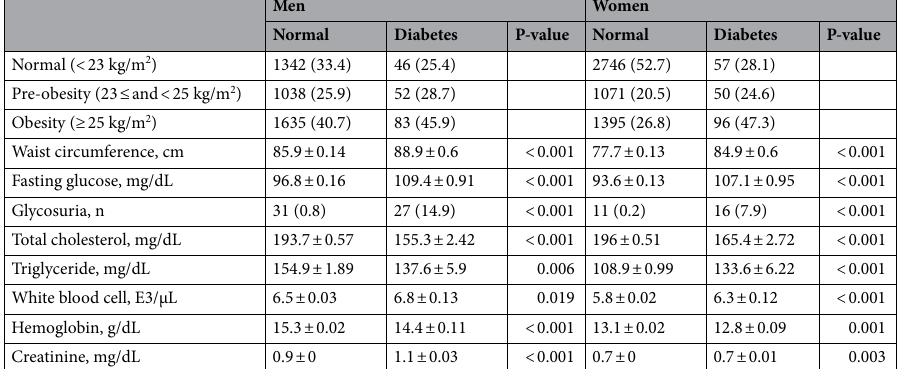
Table 1. General characteristics of training set (2013–16 KNHANES) and testing set (2017–2018) according to gender and diabetes. Continuous and categorical variables are described as mean ± standard error and number (percent), respectively. P-values are measured using nominal population, not weighted population. P-values of continuous and categorical variables are measured by Student t-test and Chi-squared test, respectively. KNHANES Korea National Health and Nutrition Examination Survey, BP blood